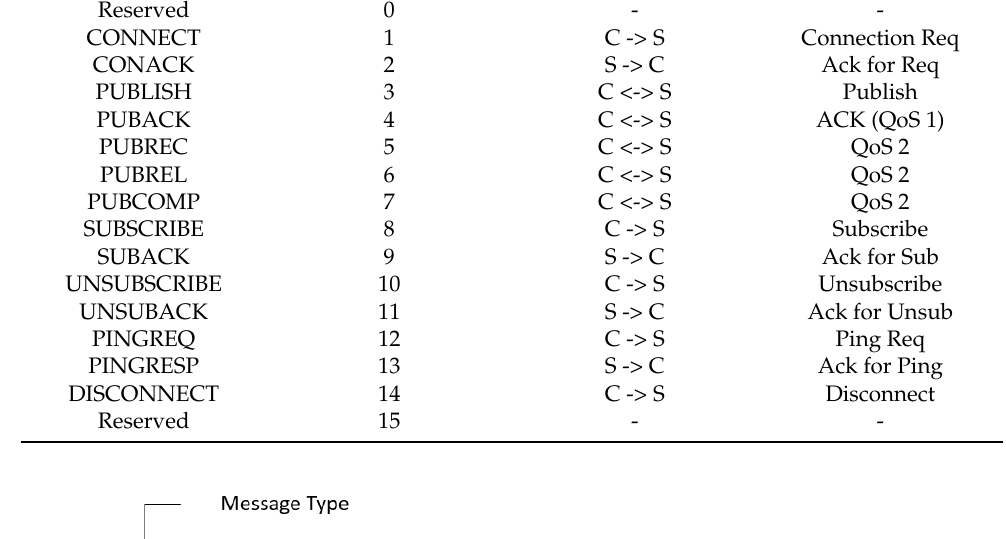
Table 1. MQTT packet types.